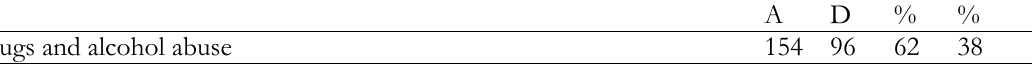
Table 4 . Behaviour of educators’ and learners’ drug and alcohol abuse